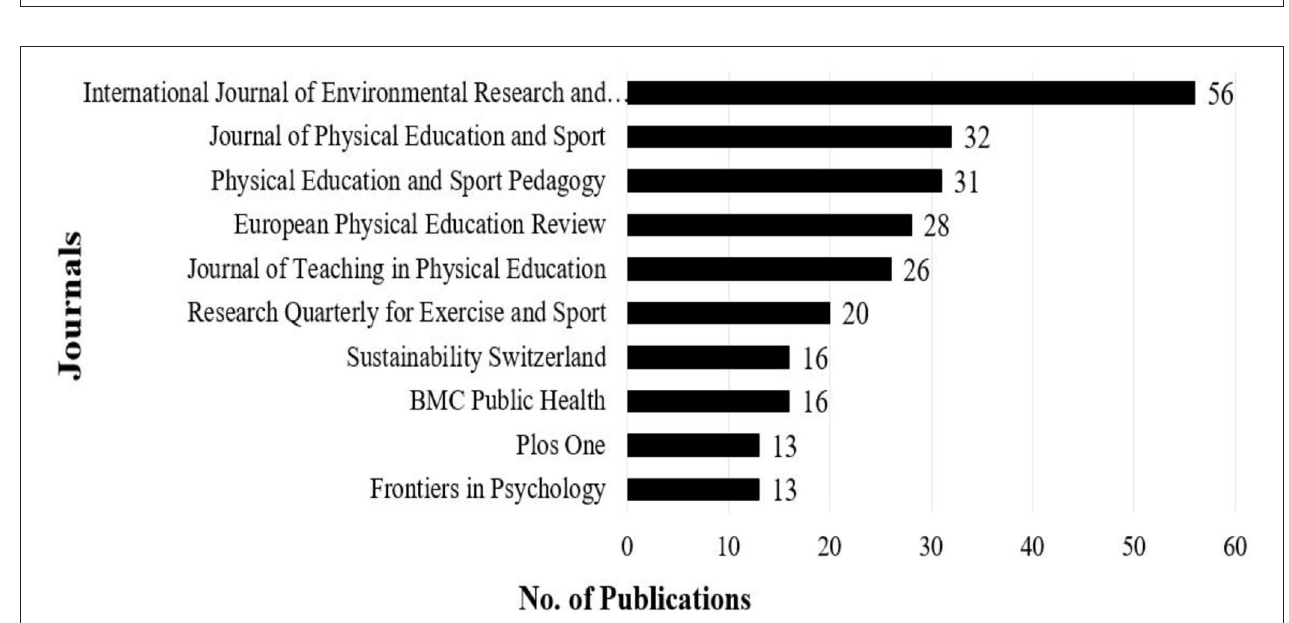
FIGURE 4 | Top 10 countries/regions of publications.